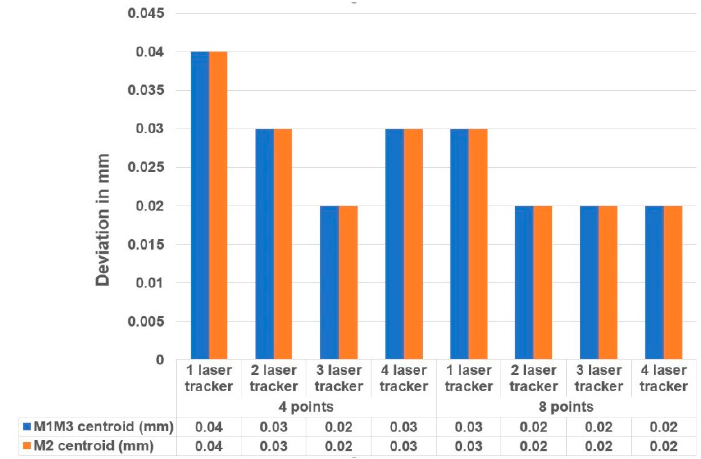
Figure 15. Measurement uncertainty of the centroid of the M1M3 and M2 mirrors.